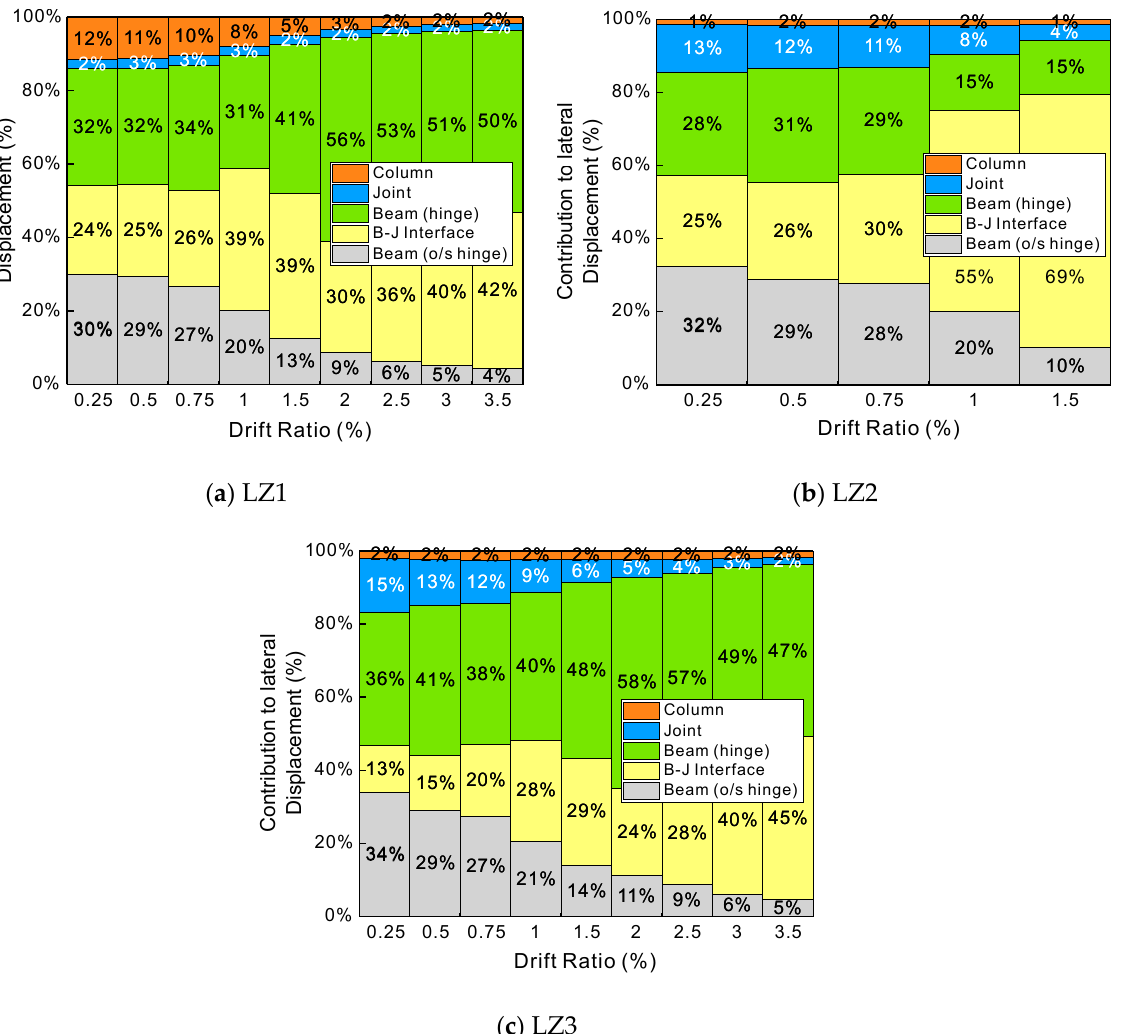
Figure 12. Components of contribution to beam lateral displacement. As can be seen, the drift contributions from the different assembly components of LZ1 and LZ3 were overall similar. The contributions from the column and joint deformations were minor and not relevant, which was consistent with the experimental observation that the column and joint were in an intact state. The primary deformation contributions came from the beam bending deformation and the rotations at the B-J interface. Note that the rotation at the B-J interface included the slip of reinforcement and the opening of flexural cracks at the